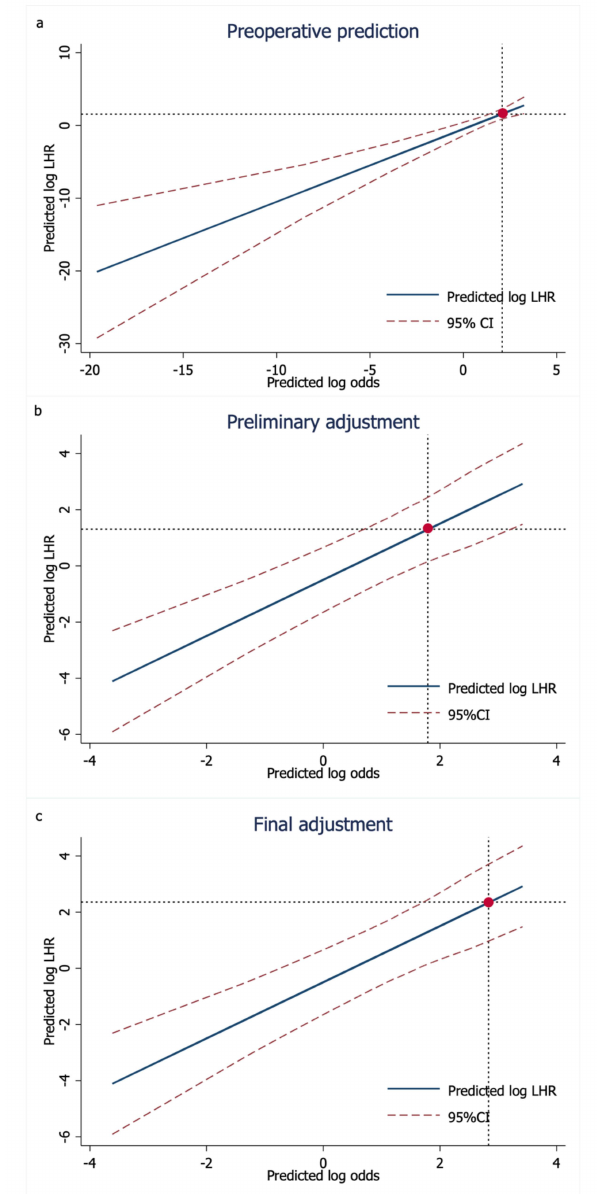
Figure A5. Predicted log-likelihood ratio (LHR) with 95% confidence interval of an example patient. ( a ) After applying preoperative information of an example patient from Table A3, the red circle